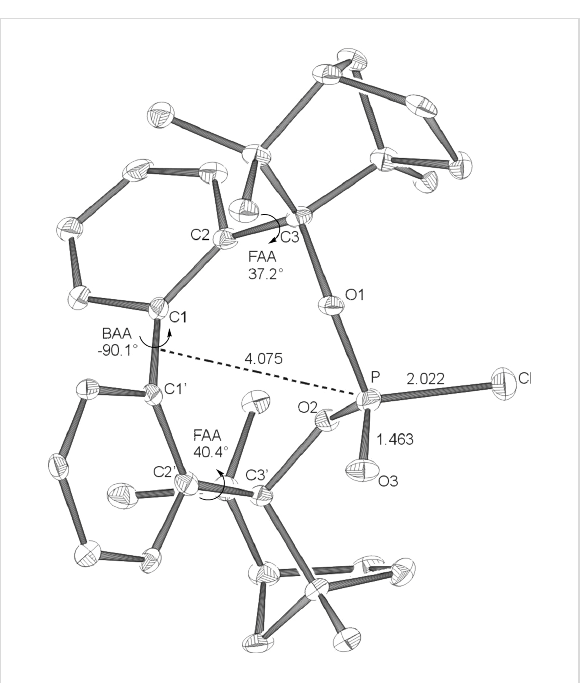
Figure 8: X-ray structures of BIFOP(O)-Cl ( 9 ). Distances are given in Å. (BAA = biaryl angle between C 2 -C 1 -C 1 '-C 2 '; FAA-lp = fenchyl-aryl dihedral angle between C 1 -C 2 -C 3 -O 1 ; FAA = fenchyl-aryl dihedral angle between C 1 '-C 2 '-C 3 '-O 2 ). The probability of ellipsoids is 40% (CCDC